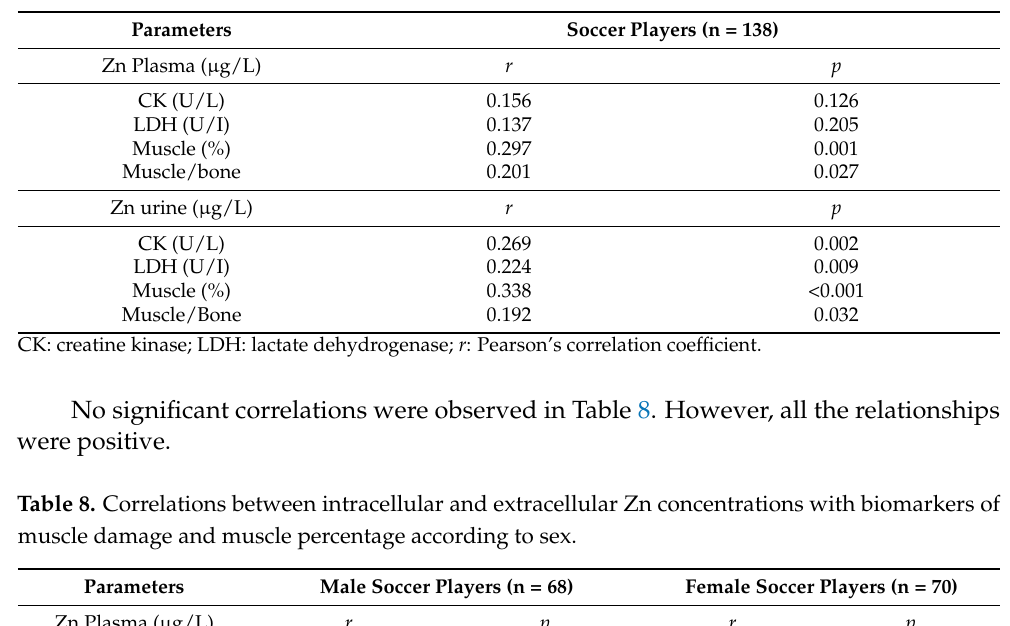
Table 7. Correlations between extracellular Zn concentration with biomarkers of muscle damage (CK and LDH) and muscle percentage without differentiating between sexes.